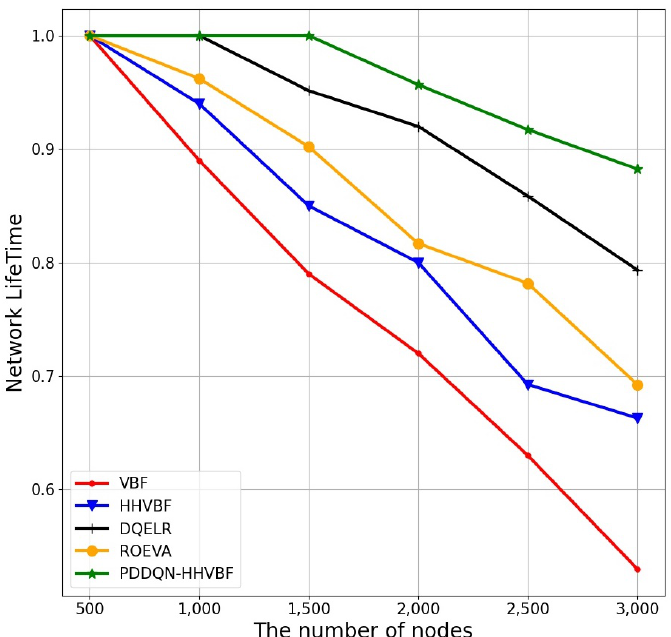
Figure 19. The network lifetime of VBF, HHVBF, DQELR, ROEVA, and PDDQN-HHVBF protocol in different number of network